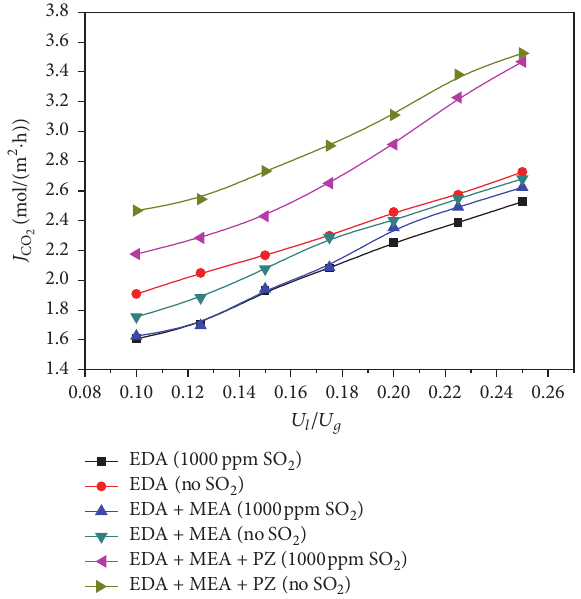
Figure 10: Influence of SO 2 on the CO 2 mass transfer rate in different liquid-gas flow rate ratios ( T = 288 K